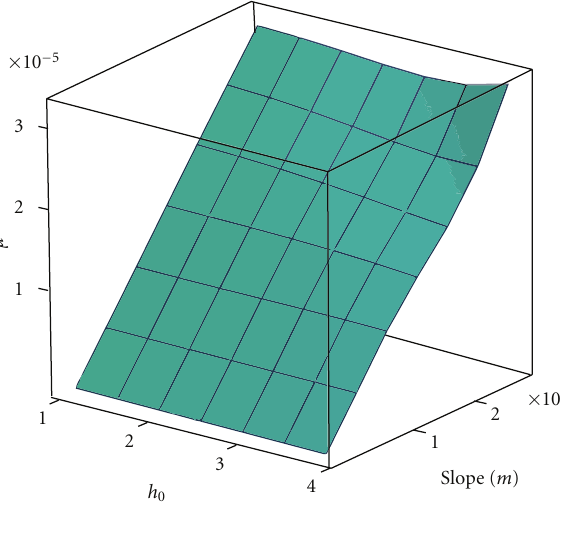
Figure 23: μ ( h 0 , m ) for β s = 500 and a =